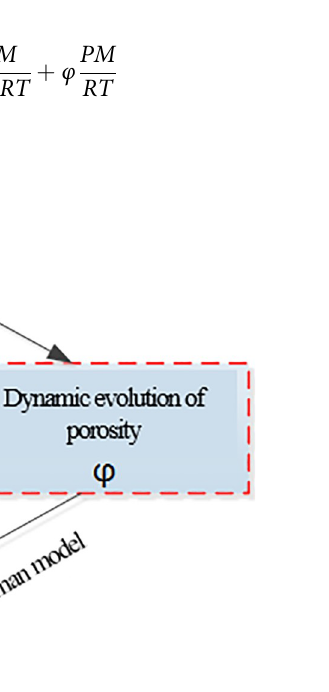
Fig 6. Fluid solid coupling relationship in gas-containing